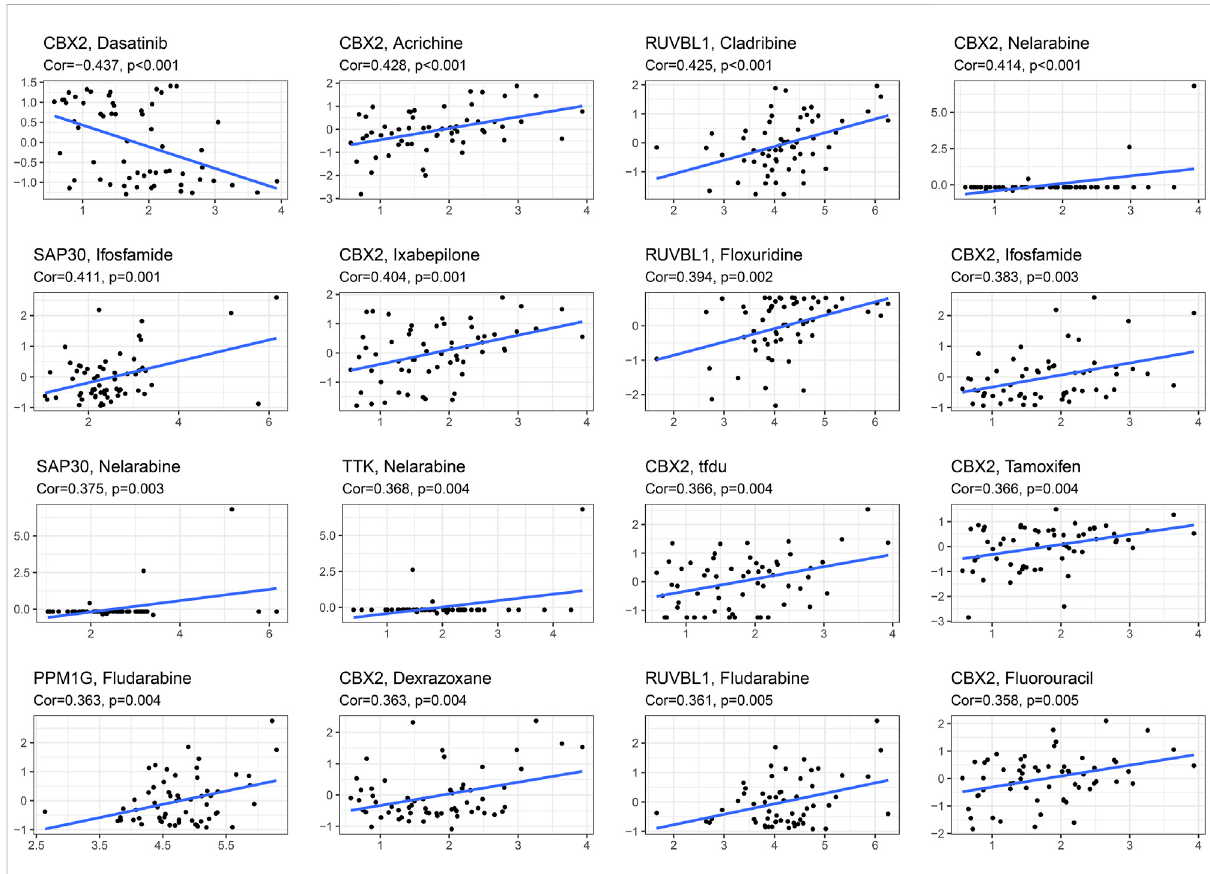
FIGURE 8 Drug sensitivity analysis based on CellMiner database, screening the fi rst 16 drugs with high correlation with gene expression in CRs prognostic